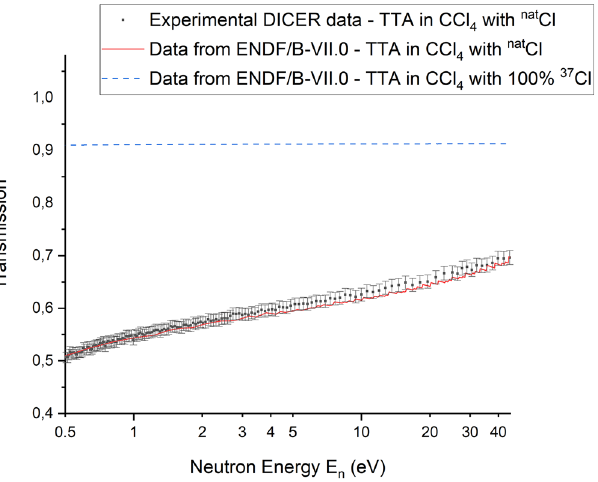
Figure 4. Measured DICER and ENDF neutron transmission through TTA/CCl 4 nat Zr target: 8 µL of CCl 4 sample with 0.3 mol·L −1 TTA with 1.4 µg of nat Zr and Pb windows. Error bars correspond to